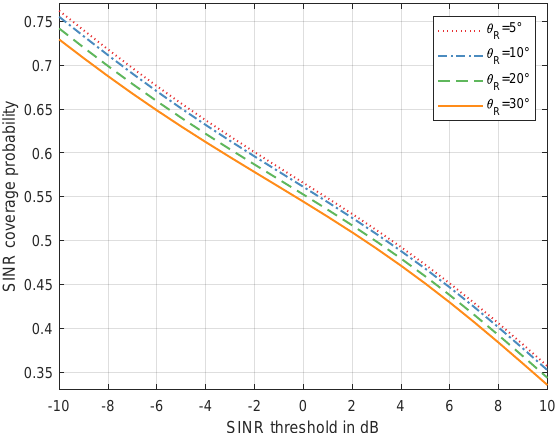
Figure 6. SINR performance with different θ R